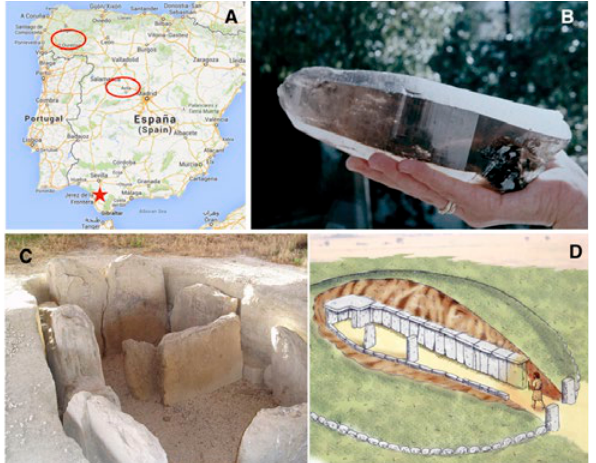
Figure 4. The dolmen of Alberite. A) The red star shows the loca- tion of Alberite in South Spain. The red circles show the possible provenance of the crystal. B) The quartz crystal found in the dol- men. Photograph courtesy of Salvador Dominguez-Bella. C) Picture of the dolmen by Pedro Cantalejo; d) Scheme of the dolmen, from the Gabinete de Bellas Artes of the Museo of Cádiz, Junta de Anda- lucía.